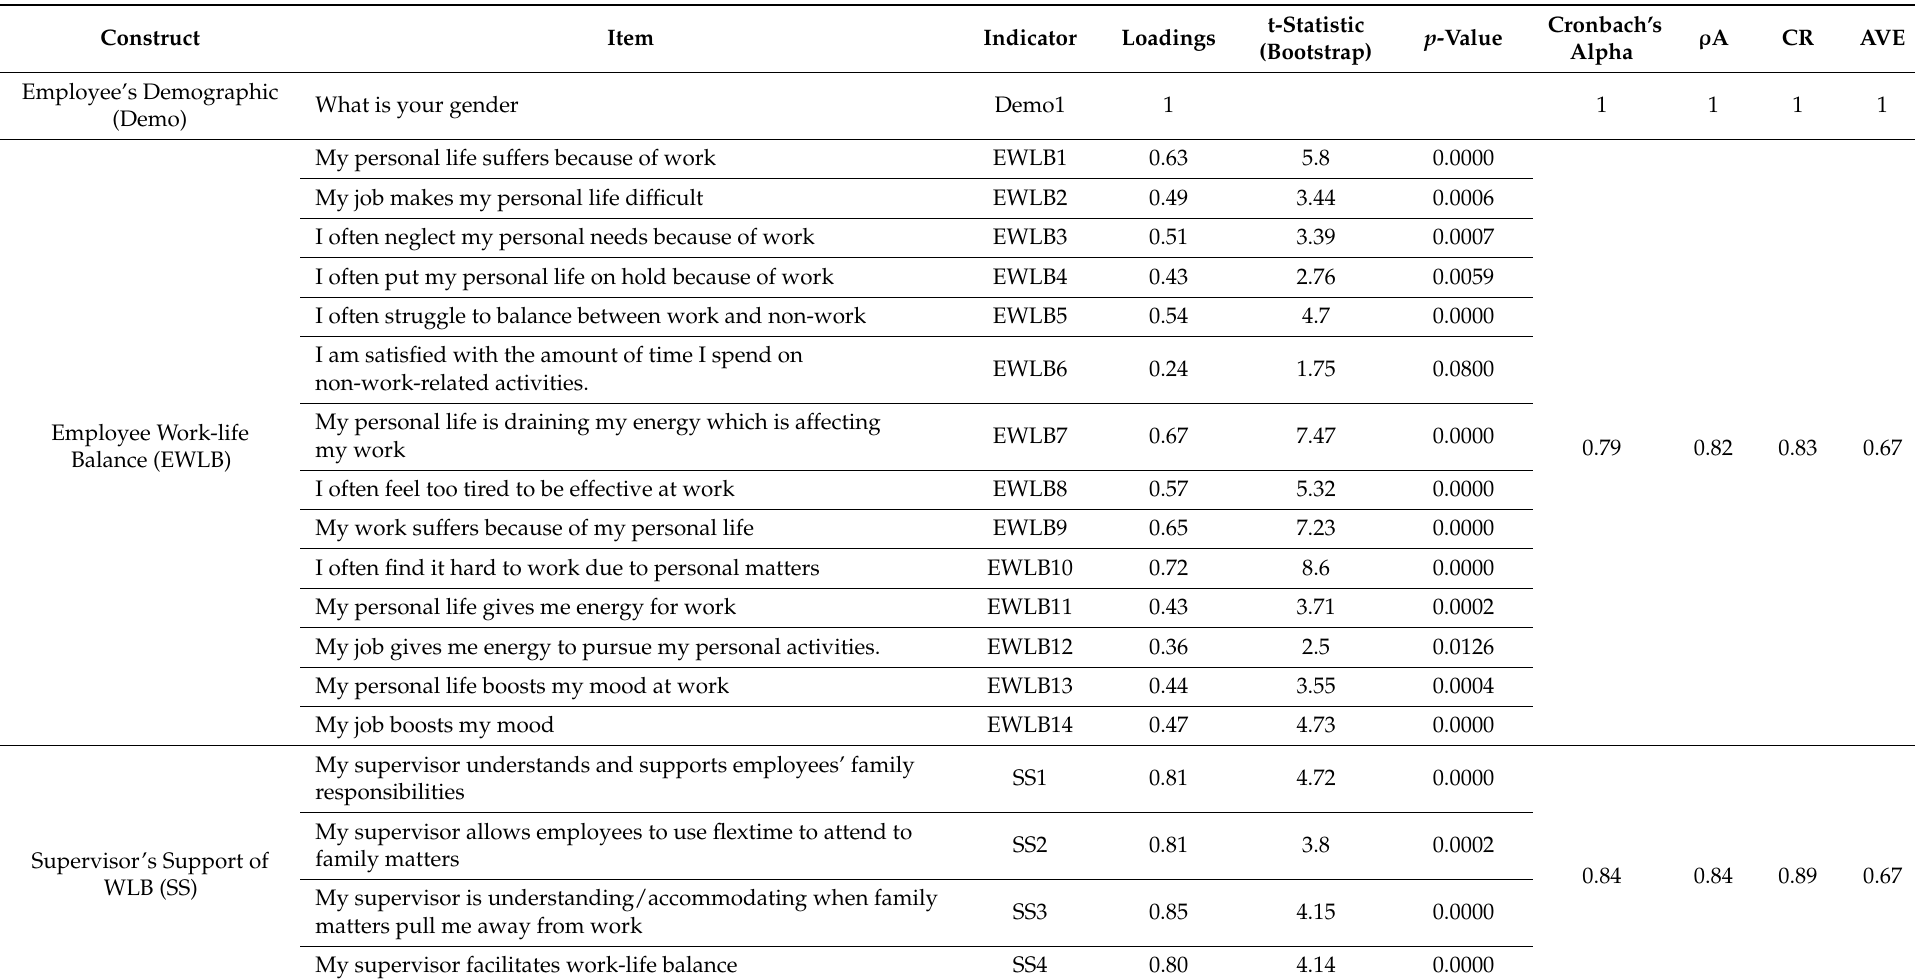
Table 3. Evaluation of Measurement